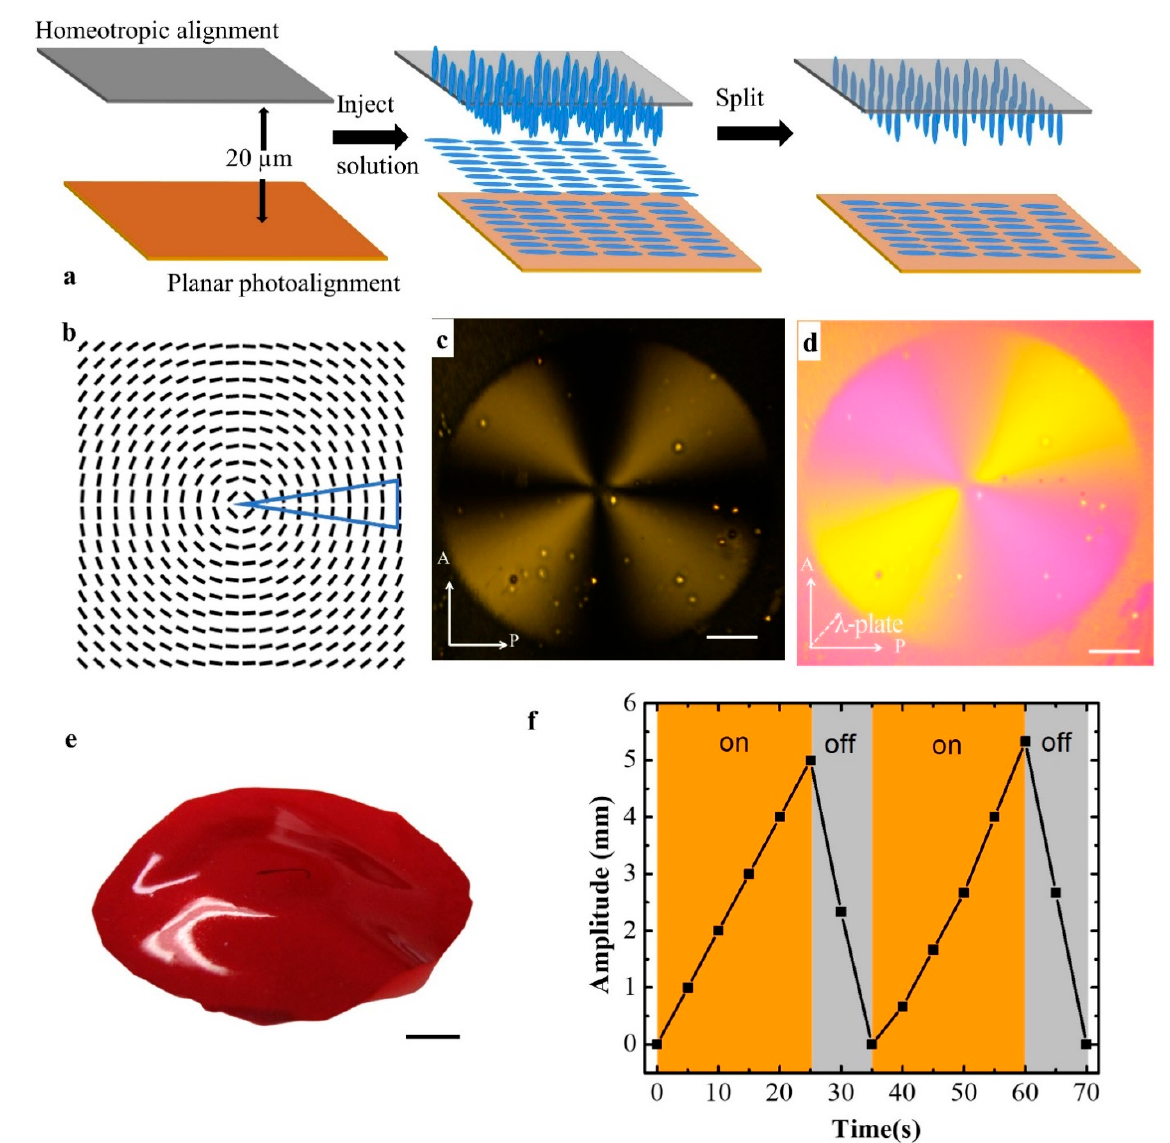
Figure 3. Fabrication of LCE film with circular +1 defect. ( a ) The LCE film fabrication process. ( b ) The director field of circular +1 defect. The blue triangle is the position of the starting segment. ( c , d ) The POM images without ( c ) and with ( d ) red plate. ( e ) A single cone is formed in LCE film with the bottom surface of a circular +1 defect. ( f ) The dependence of the amplitude of the LCE film on light irradiation. The scale bars are 2.5 mm.